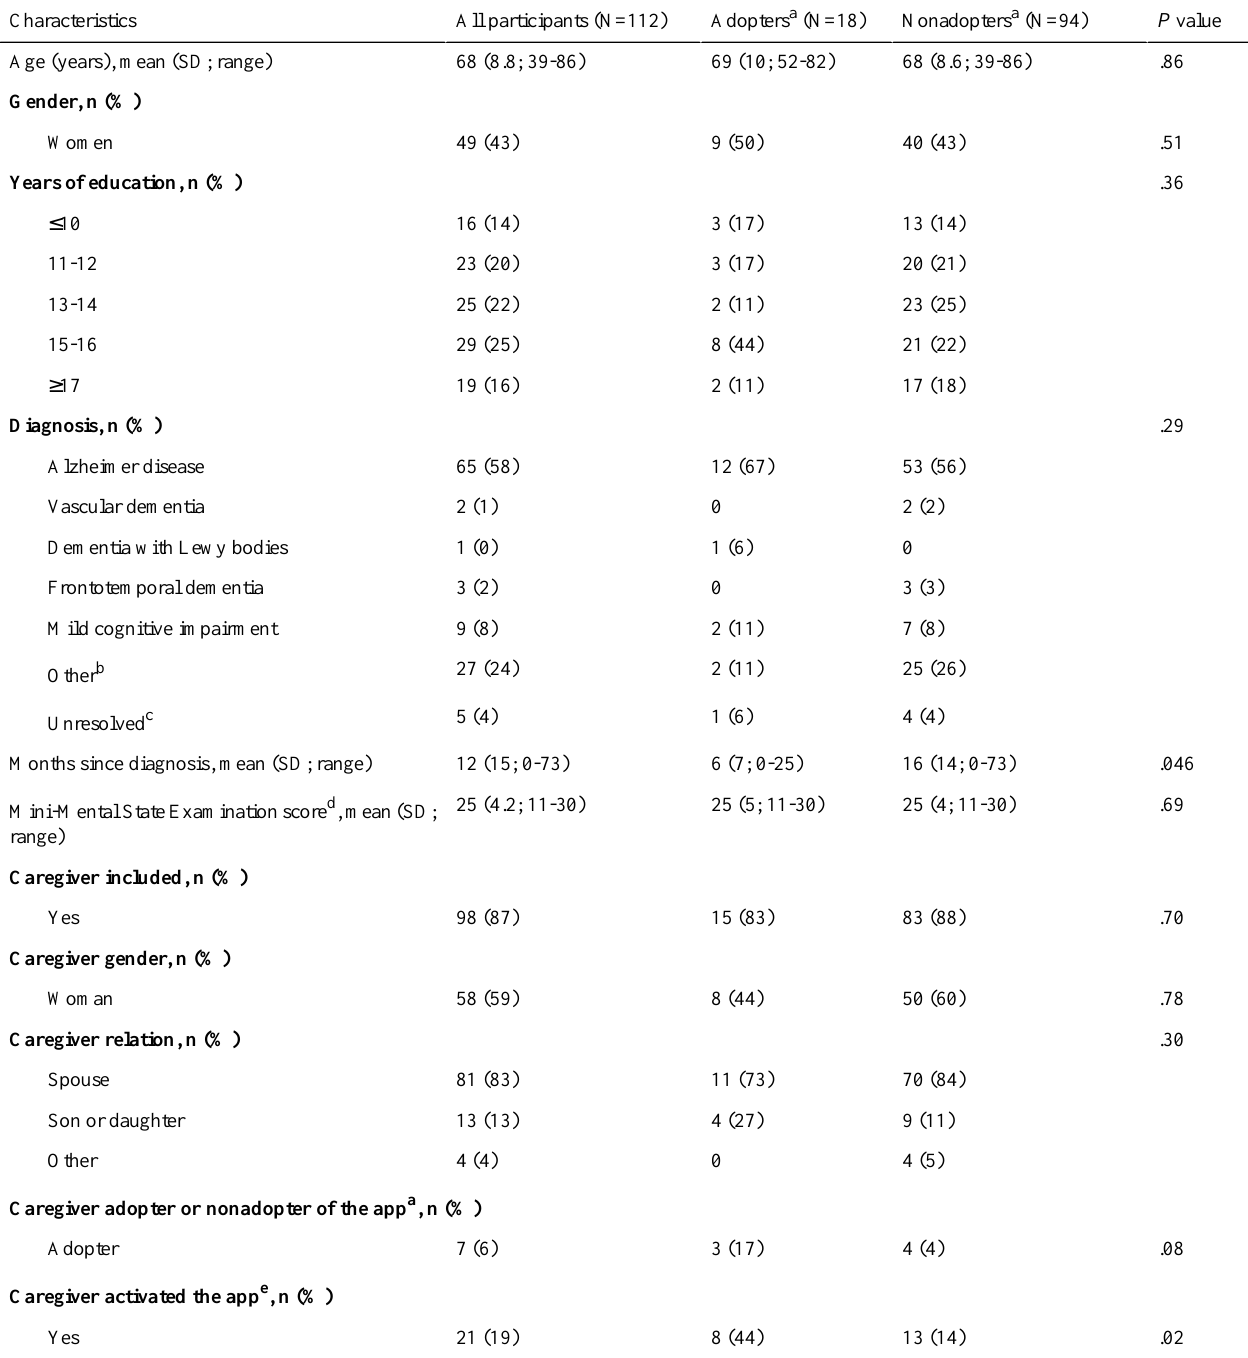
Table 1. Characteristics of participants and caregivers and differences between adopters and